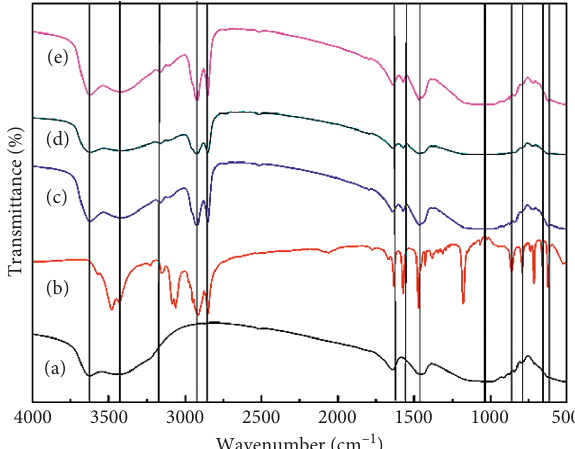
Figure 2: FTIR analyses of MMT and C (b) C 16 mimCl, (c) 30%, (d) 10%, and (e)